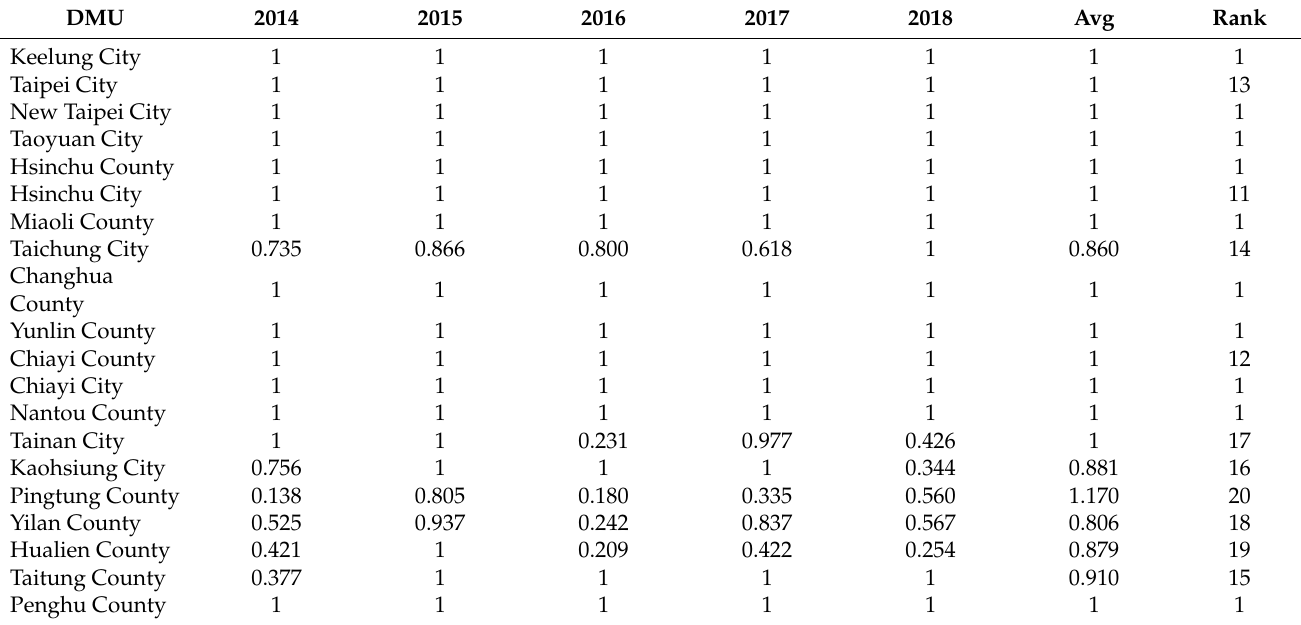
Table 5. Disaggregated efficiency of desirable output (Exercise expenditure).